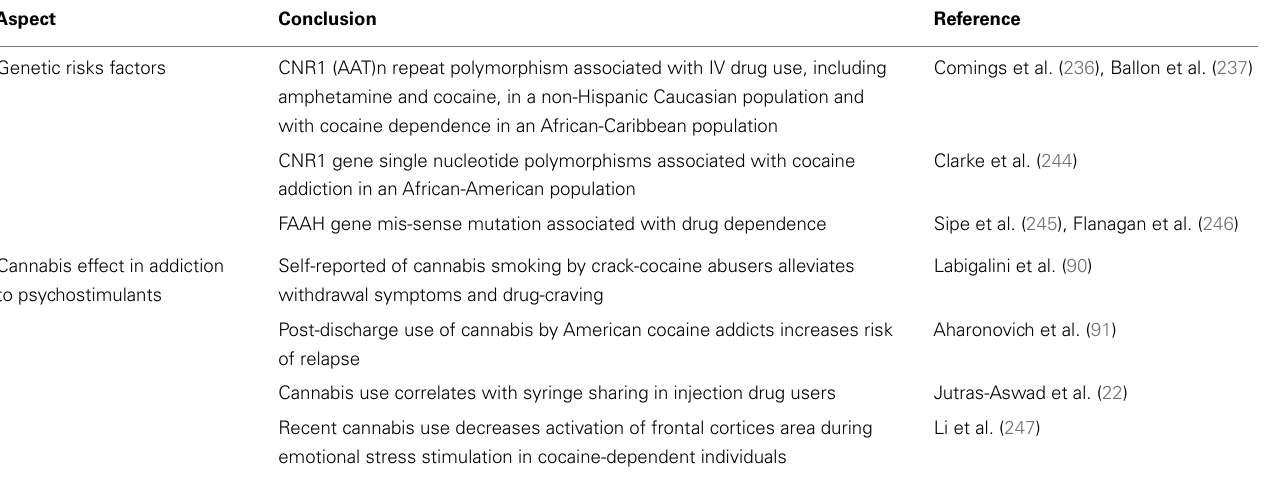
Table 1 | ECBS and factors contributing to vulnerability to psychostimulants in